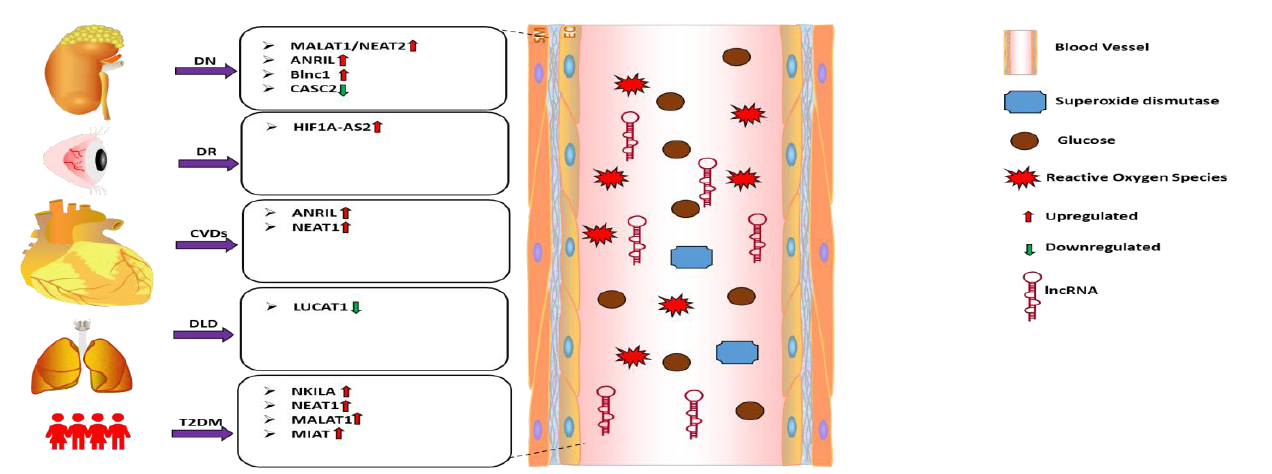
Figure 1. Roles and functions of the listed lncRNAs in the regulation of oxidative stress in diabetic complications. Arrows indicate the direction of changes in the expression or function. DN: Diabetic nephropathy; DR: Diabetic retinopathy; CVDs: Cardiovascular diseases; DLD: Diabetes lung disease; T2DM: Type 2 diabetes mellitus; lncRNA: Long non-coding RNA; MALAT1: Metastasis-associated lung adenocarcinoma transcript 1; ANRIL: Antisense non-coding RNA in the INK4 locus; Blnc1:Brown Fat lncRNA 1; CASC2: Cancer susceptibility candidate 2; HF1A-AS2: Hypoxia inducible factor 1 alpha-antisense RNA 2; NEAT1: Nuclear paraspeckle assembly transcript 1; LUCAT1: Lung cancer associated transcript 1; NKILA: NF-κB-interacting long noncoding RNA;MIAT: Myocardial infarction-associated transcript.